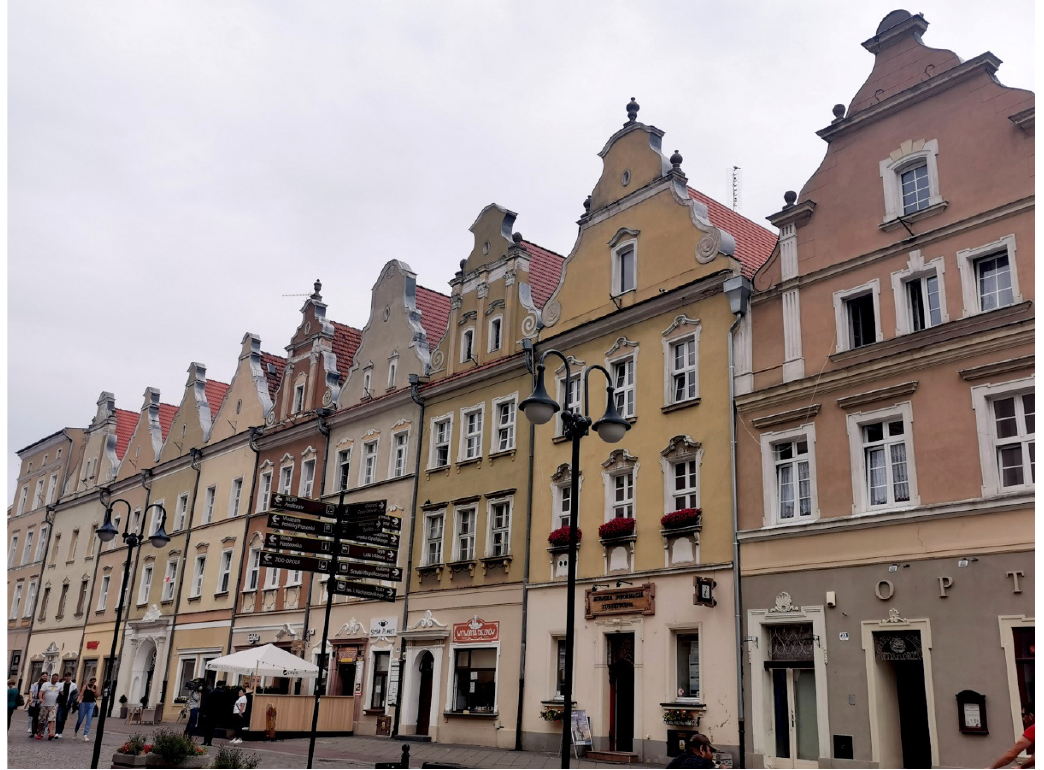
Figure 4. Eastern frontage of the Market Square in Opole